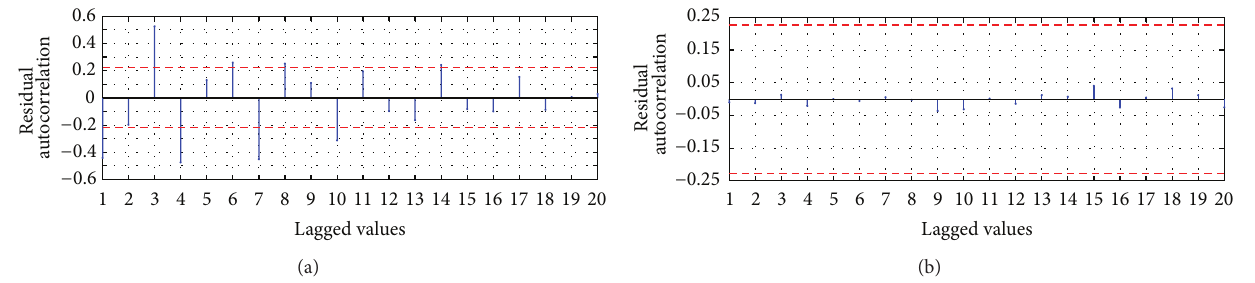
Figure 14: Residual ACF: (a) MA-ANN-RPROP(9,10,1) and (b) HSVD-ANN-RPROP(9,11,1).